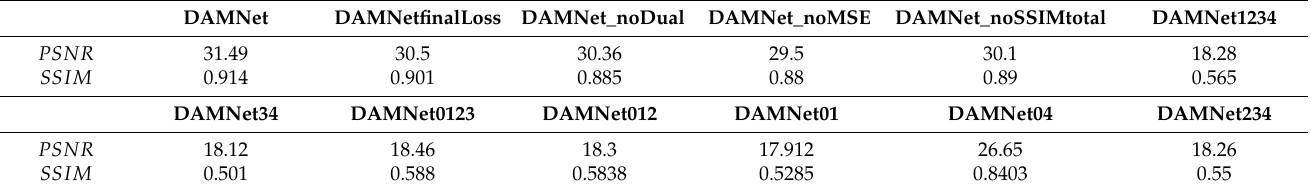
Table 6. The ablation of DAMNet on Rain100H, approaching the relationship of the